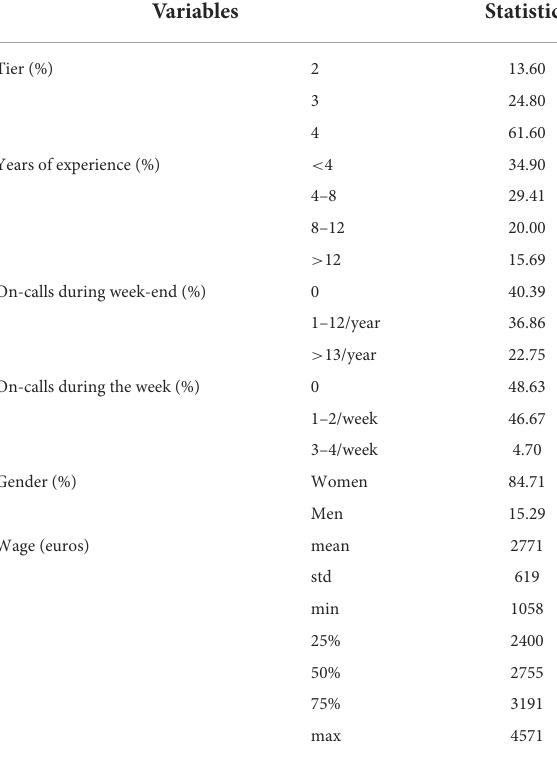
TABLE 1 Descriptive statistics of the sample